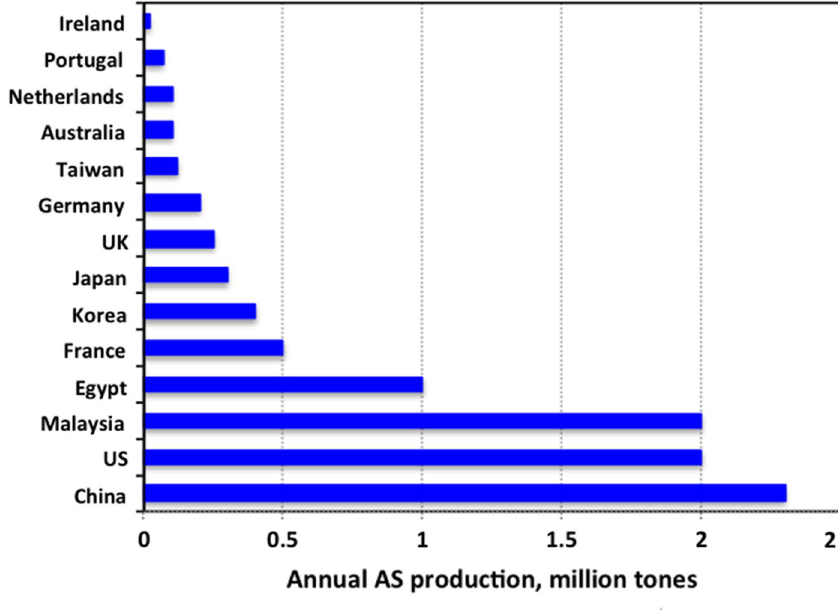
Fig. 2 Estimated alum sludge production quantities in some selected